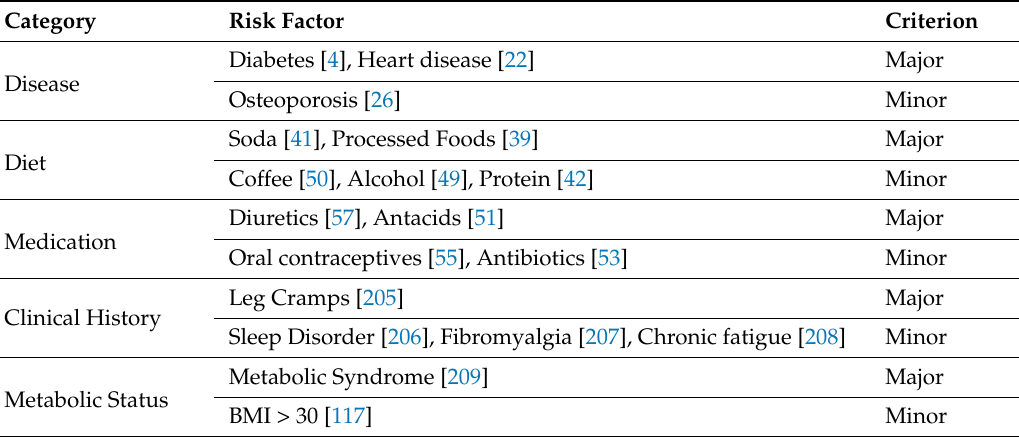
Table 2. Suggested illustrative criteria for assessment of magnesium